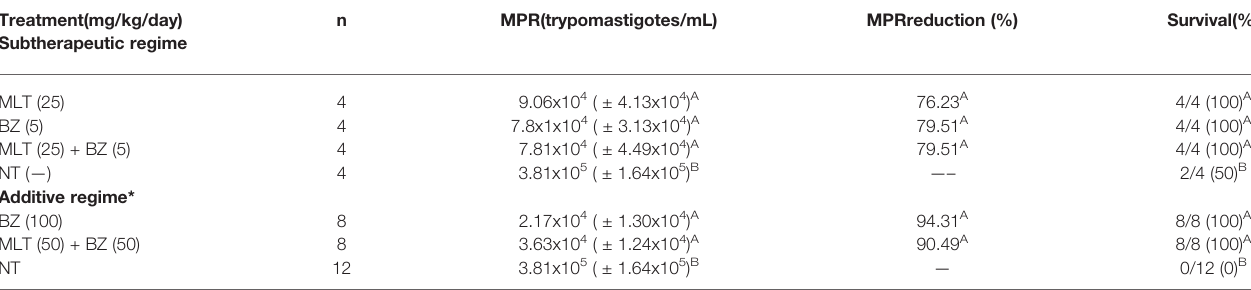
TABLE 2 | Effect of miltefosine alone or combined with benznidazole on parasitemia parameters in BALB/cJ mice infected with Trypanosoma cruzi (VD strain). Treatment(mg/kg/day)